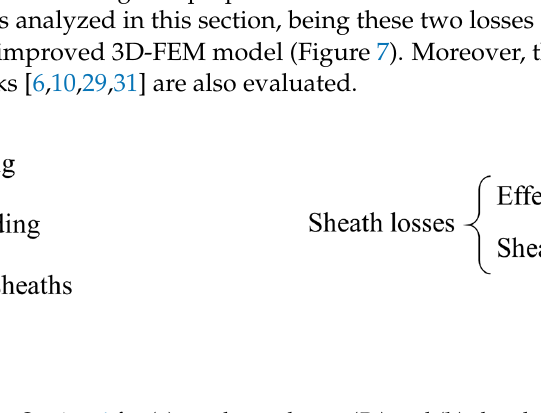
Figure 7. Analysis developed in Section 4 for ( a ) conductor losses ( P c ) and ( b ) sheath losses ( P s ).